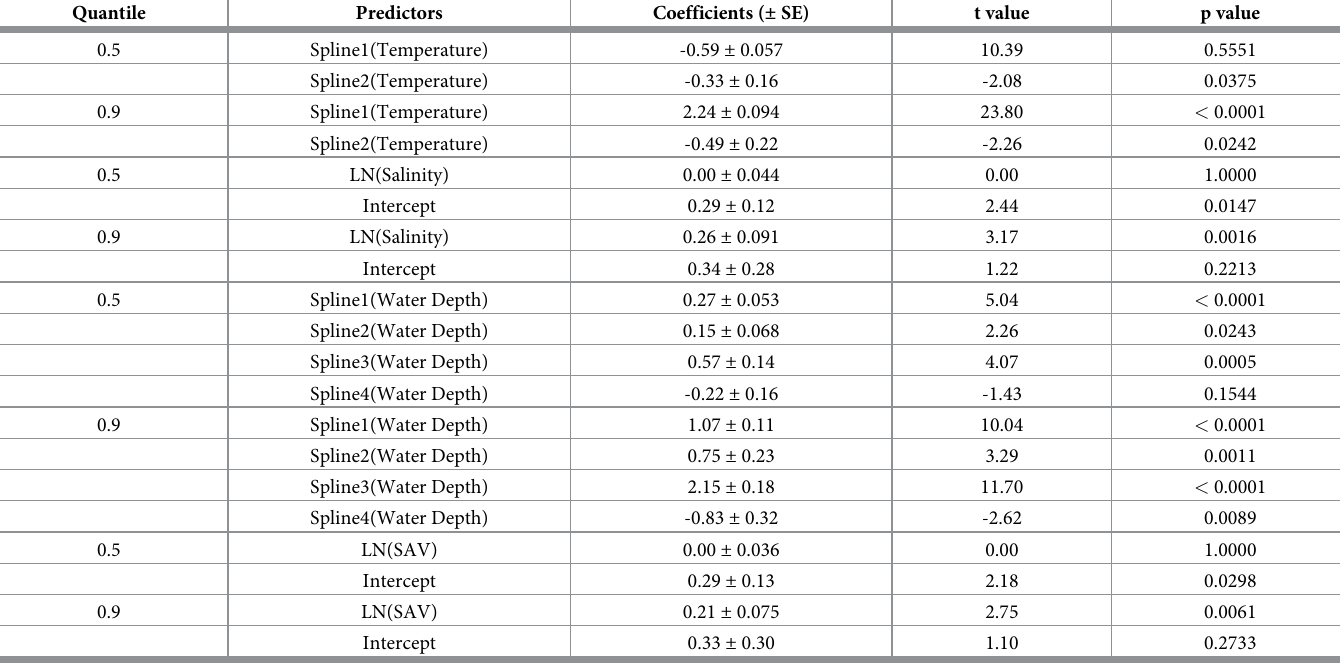
Table 3. Statistical significance of 0.5 and 0.9 quantile regressions of pink shrimp density (shrimp m -2 : LN([x+1]) against temperature (˚C), salinity (ppt), water depth (m), and submerged aquatic vegetation (SAV: % cover).